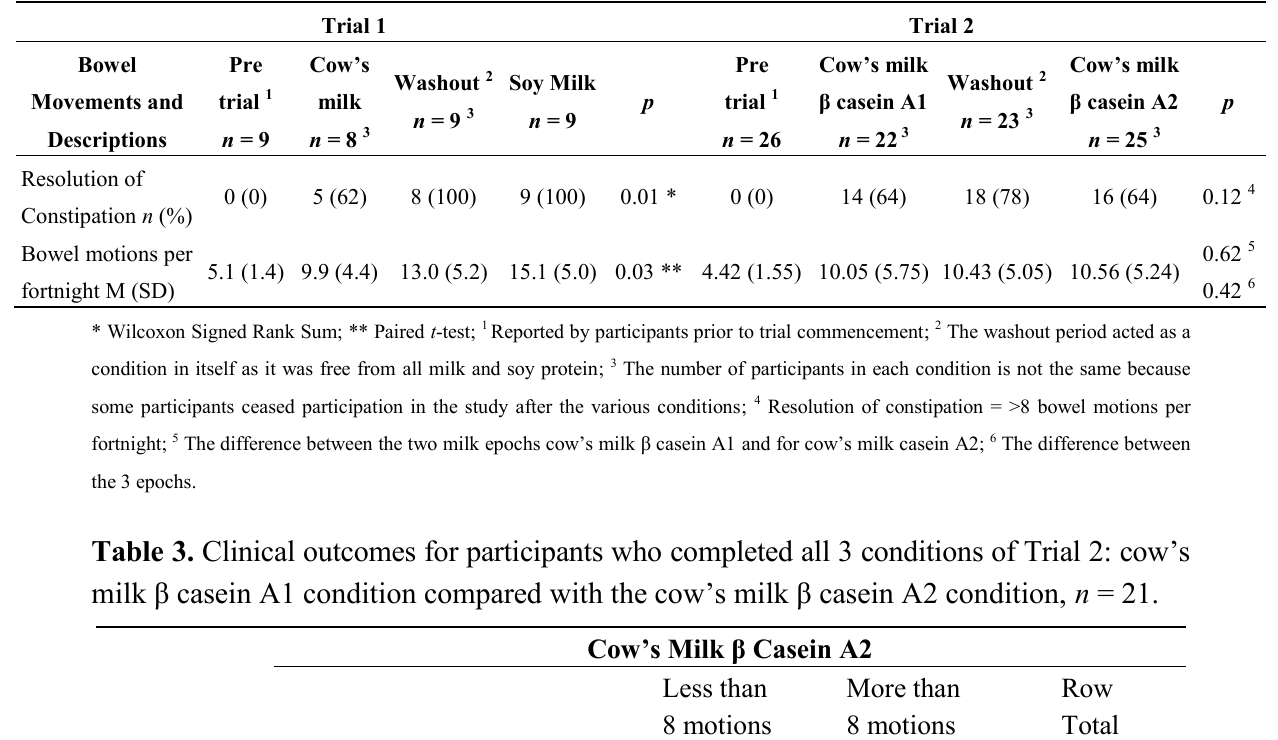
Table 2. Cases of resolution (greater than 8 bowel motions per fortnight) of constipation and mean bowel motions during a 2 week condition for Trial 1 and Trial 2.